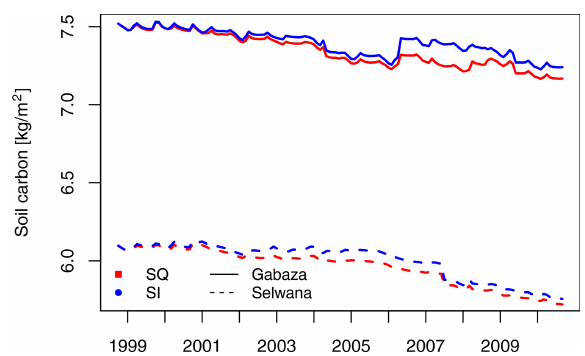
Figure 5. Time series of the cropland soil organic matter (SOC) content at Gabaza and